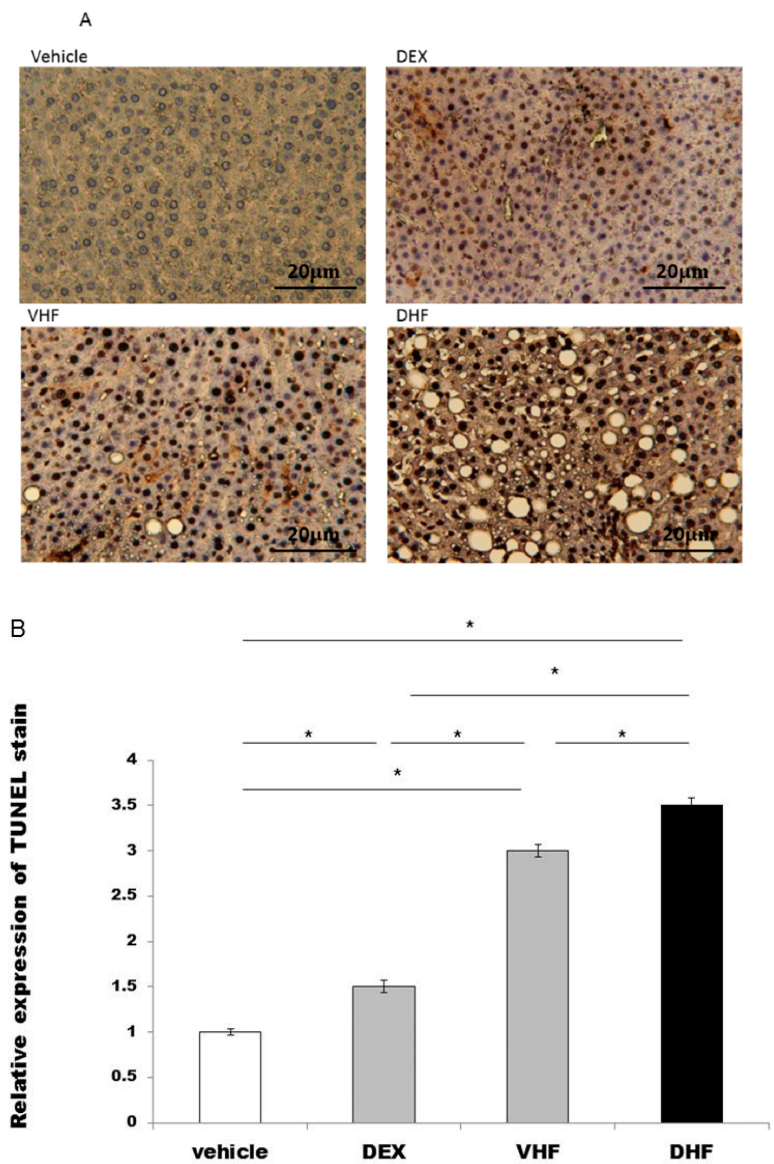
Figure 2. The extent of TdT-mediated dUTP Biotin Nick End Labeling (TUNEL) staining was assessed for whether apoptosis was involved in this liver damage. ( A ) It was overexpressed in the prenatal DEX exposure plus postnatal HF diet group (DHF treated group), prenatal DEX exposure group (DEX treated group) and postnatal HF diet group (VHF treated group) compared to the vehicle treated group; ( B ) Semi-quantification of the TUNEL stained cells. All the results represent mean ˘ standard error of six animals, * p < 0.05. The letters above each represented different groups as in Figure 1 (original magnification 400 ˆ ; bar = 20 µ